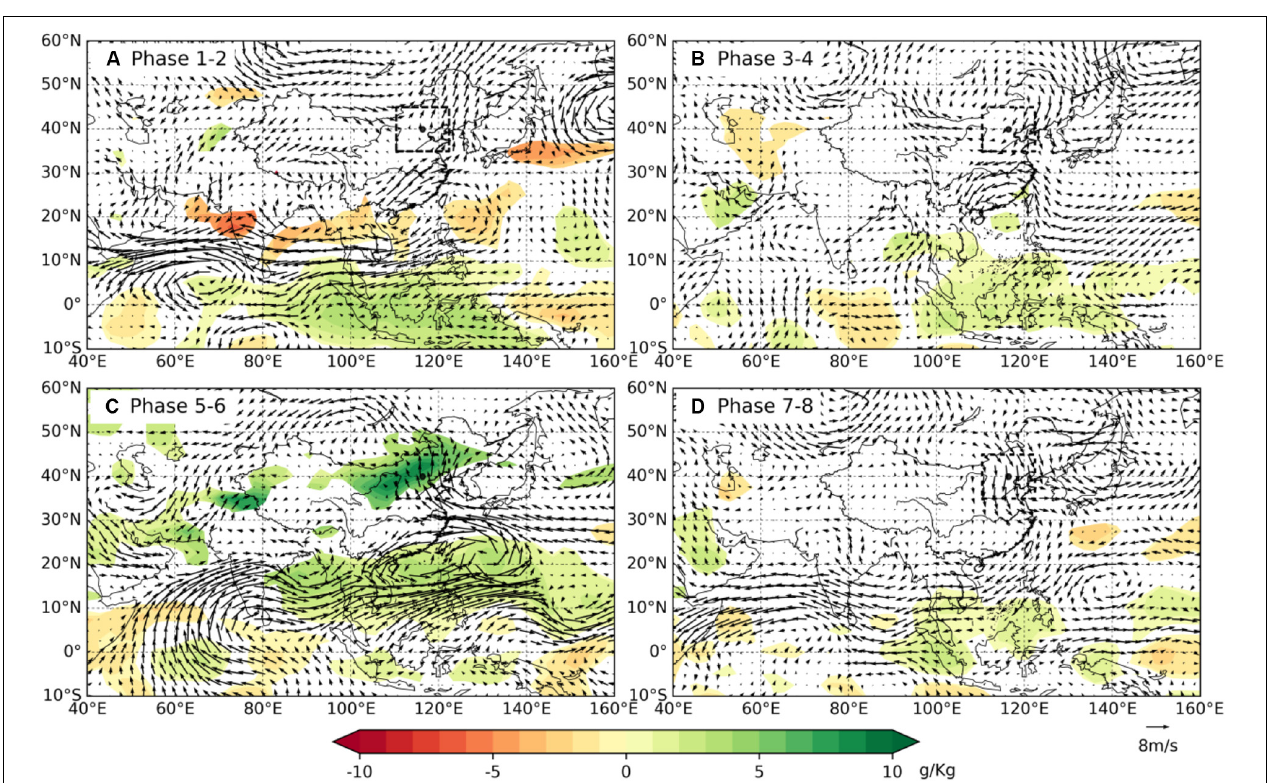
FIGURE 6 | Composites of anomalous wind at 850 hPa in each phase of MJO in the summer of 2018. Unit: m · s − 1 . The shaded areas are the convergence or divergence of water vapor (shaded areas exceed the 95% confidence level). Unit: g · kg − 1 . (A) The Composite map of horizontal wind field anomaly(arrow) and specific humidity field anomaly(shaded areas, passed 95% significance level) on 850hPa layer corresponding to the phase 1-2 of MJO. (B–D) The same, but corresponding to the 3-4, 5-6, 7-8 phases of MJO.